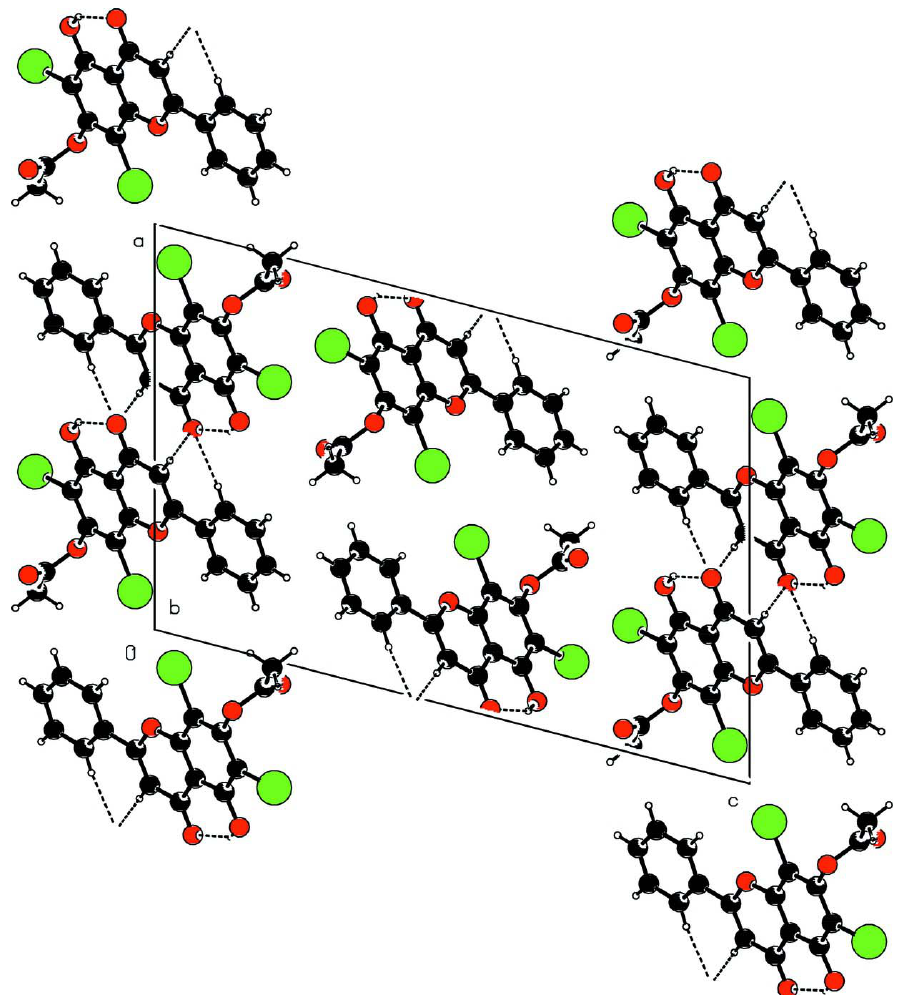
Figure 2 The molecular packing viewed down the b -axis. Dashed lines represent the weak C–H···O interactions within the lattice.